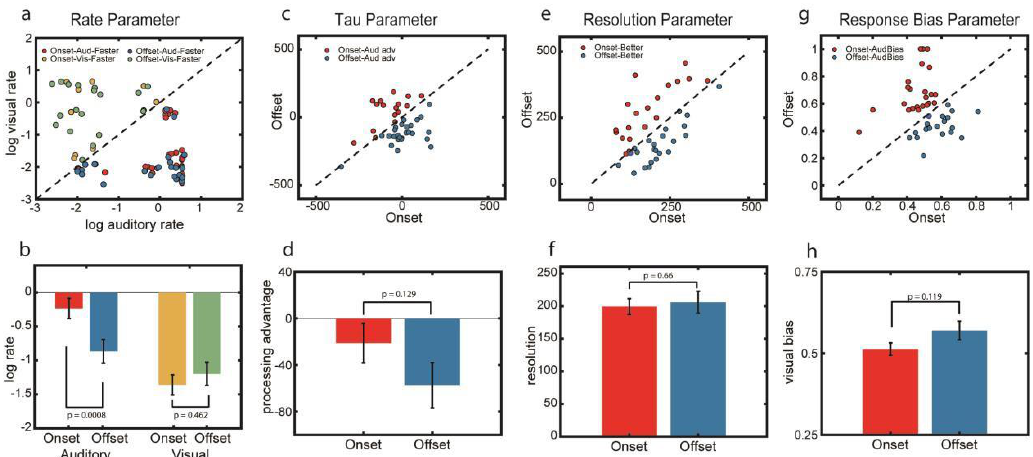
Figure 5. Parameter values of the best fitting models for onset and offset data (i.e., data pooled and binned from staircase sequences as described in the section under psychometric functions. ( a ) Scatterplots showing the log-transformed auditory and visual rate parameter values for both onset and offset tasks for each participant ( N = 42, see text for details of the modelling results). Red and blue dots represent participants who showed faster auditory rate (that is, compared to visual) for the onset and offset tasks respectively while gold and green dots represent participants who showed faster visual rate for the onset and offset tasks, respectively; ( c ), ( e ), and ( g ) Scatterplots showing values for the tau, resolution, and bias parameters for both onset and offset tasks; ( b ), ( d ), ( f ), and ( h ) Averaged parameter values for both onset and offset tasks. Error bars represent standard errors of the mean.